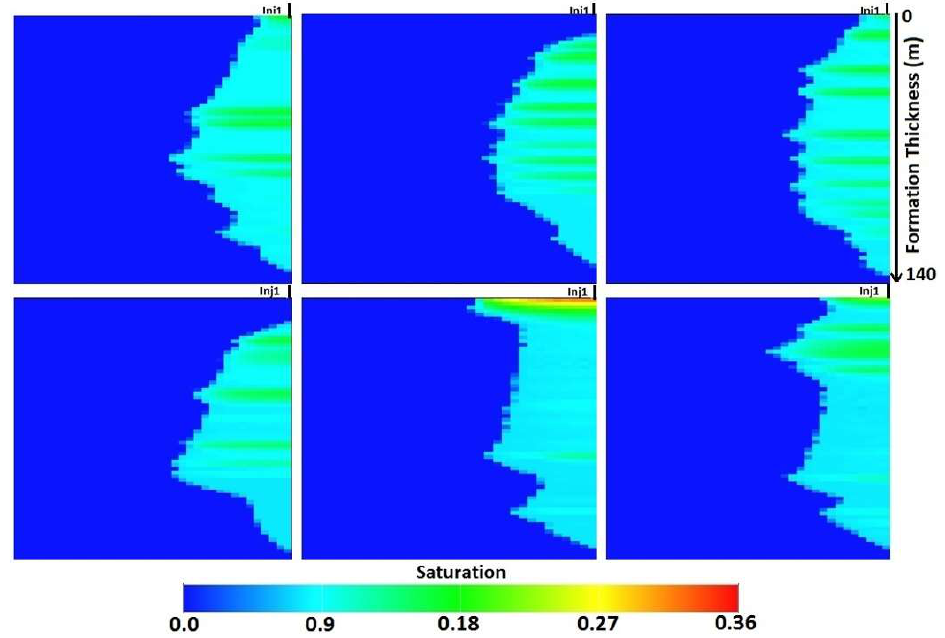
Figure 8. Gas saturation distribution after 120 years in 6 different cases.